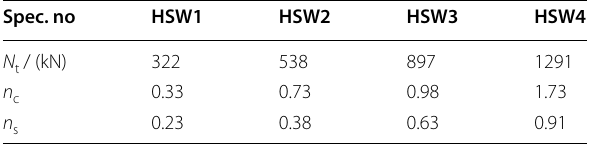
Table 2 Axial tensile force values of RC wall